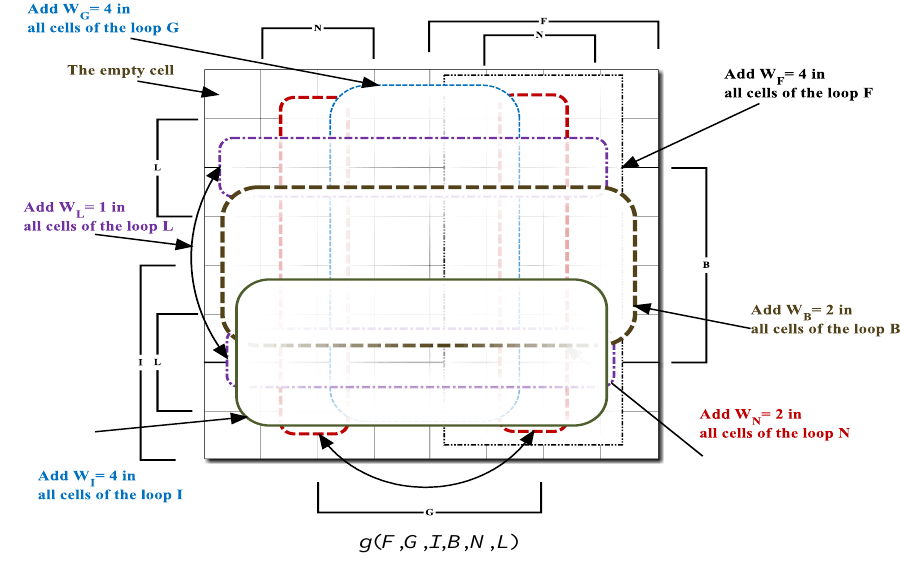
Fig. 1. Use of half-map loops to enter the weights in the pseudo switching function 𝑔(𝐹, 𝐺, 𝐼, 𝐵, 𝑁, 𝐿) =